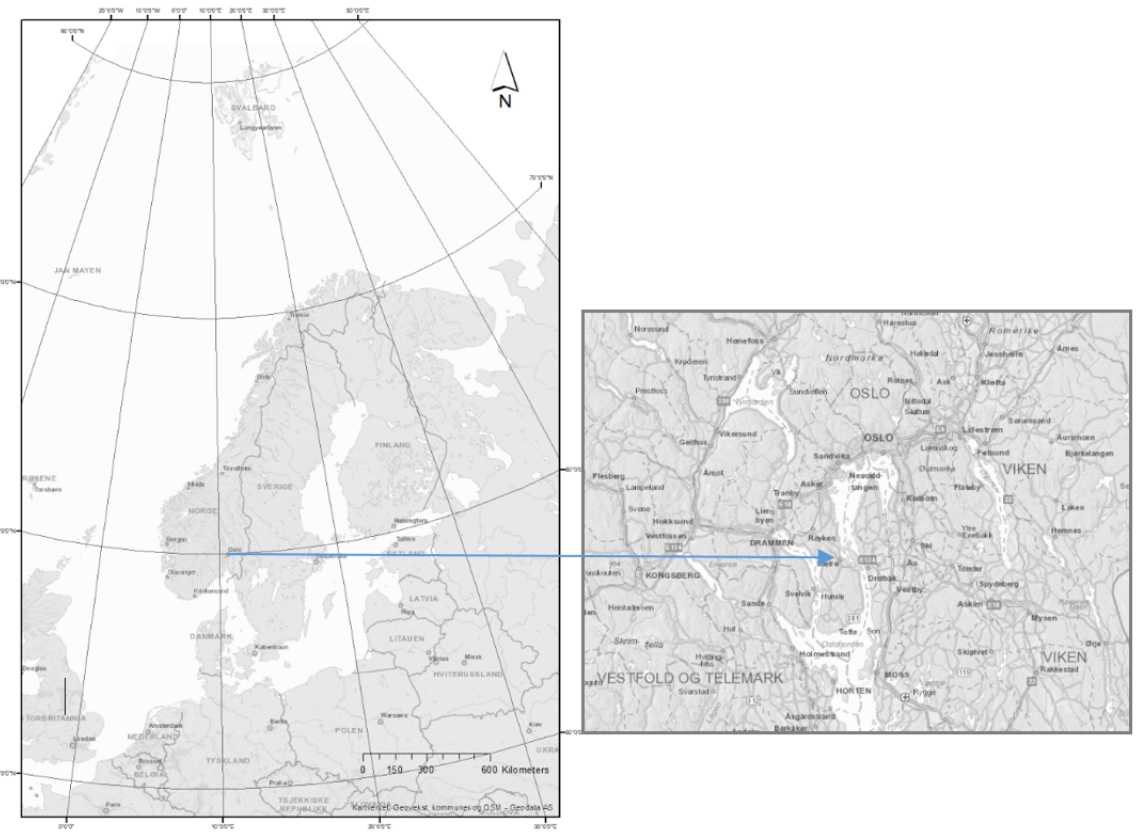
Figure 1. Map of Norway and section of Asker.